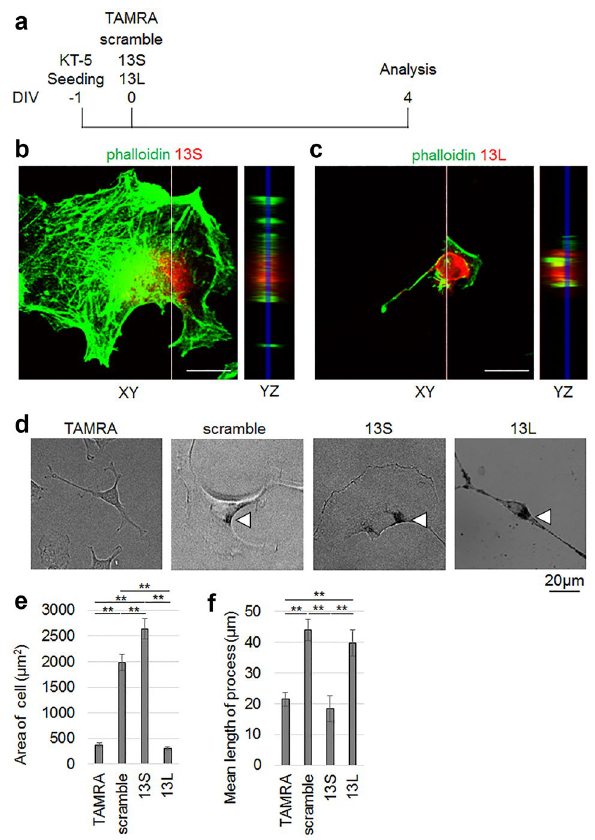
Figure 3. Incorporation of aggregated 13S and 13L affects differentiation of KT-5 astrocytic cells. ( a ) Time schedule of the experiment. ( b , c ) Ortho YZ-axis cross section images (right) along the white line in the XY-axis view (left) was reconstructed from the z-stacks. The fluorescent signals of 13S ( b ) (red) and 13L ( c ) (red) are found between phalloidin signals (green). ( d – f ) Total area of cell ( e ) and averaged length of each process per cell ( f ) of KT-5 cells given with TAMRA, scrambled serine, 13S or 13L were quantified (n = 30 cells, each from 3 experiments). Representative images are shown in ( d ). Arrowheads indicate aggregates. Error bars represent SE. ANOVA, ** p < 0.01. Scale bars, 20